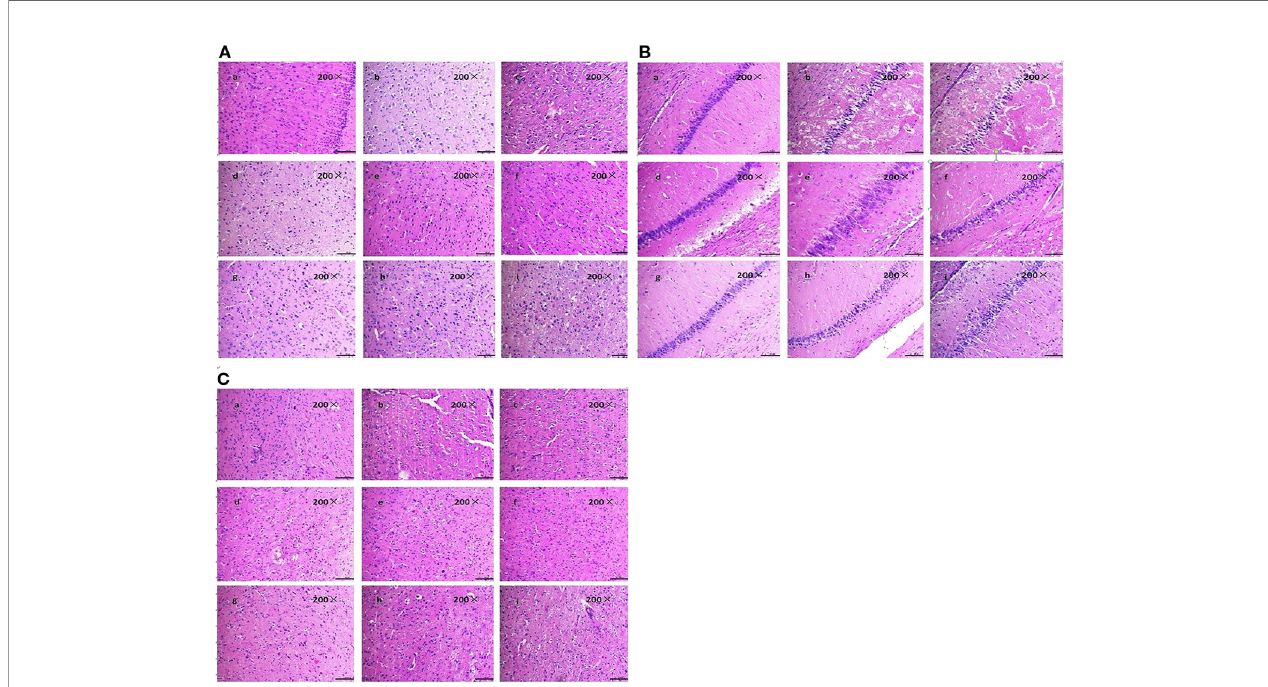
FIGURE 3 | Effect of BZP on Morphological changes in Cortex, Hippocampal and Striatum in MCAO rats under inverted microscope (200×). (A) Morphological changes in Cortex; (B) Hippocampal; (C) Striatum. The groups were as follows: (a) Sham group, (b) Model group, (c) BZP (0.6 mg/kg), (d) BZP (1.2 mg/kg), (e) BZP (2.5 mg/kg), (f) BZP (5 mg/kg), (g) BZP (10 mg/kg), (h) BZP (20 mg/kg), (i) C8E4 (10